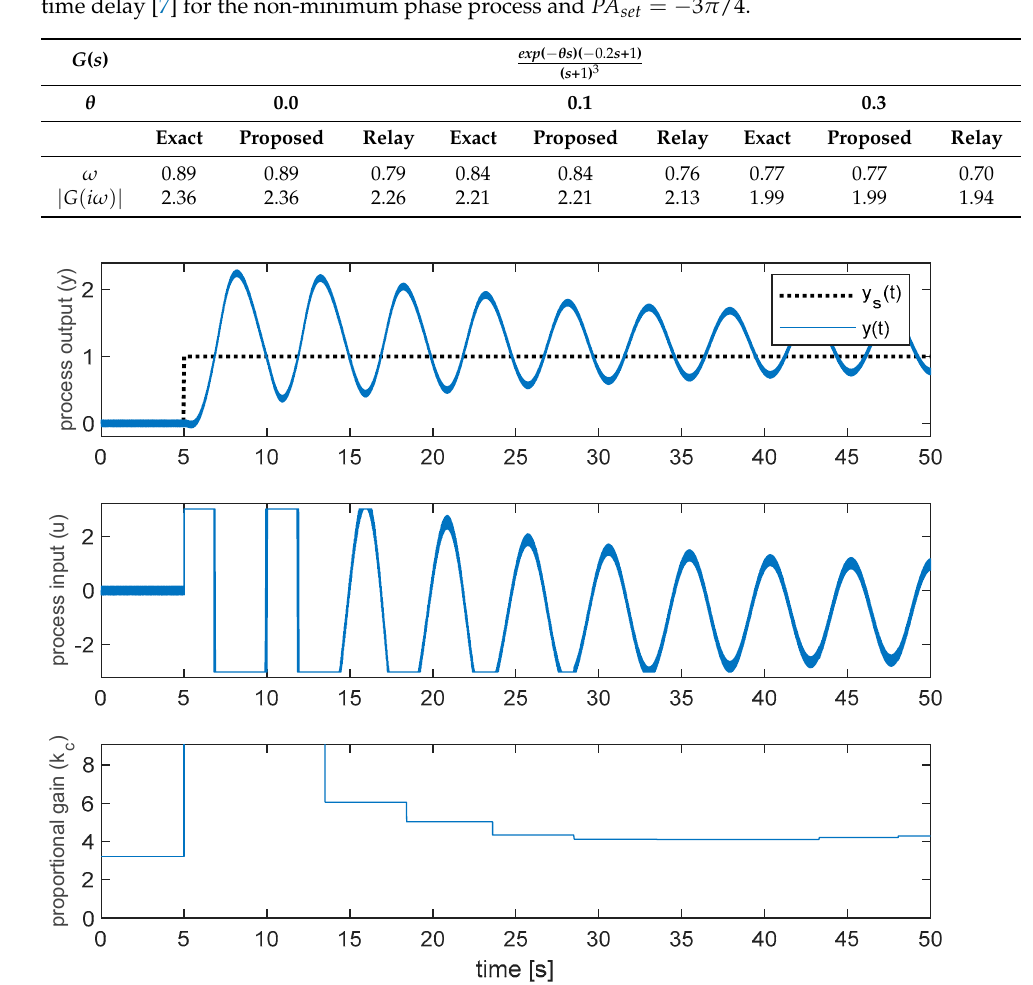
Figure 13. Response of the proposed method for the non-minimum phase process with θ = 0.1 and PA set = − π